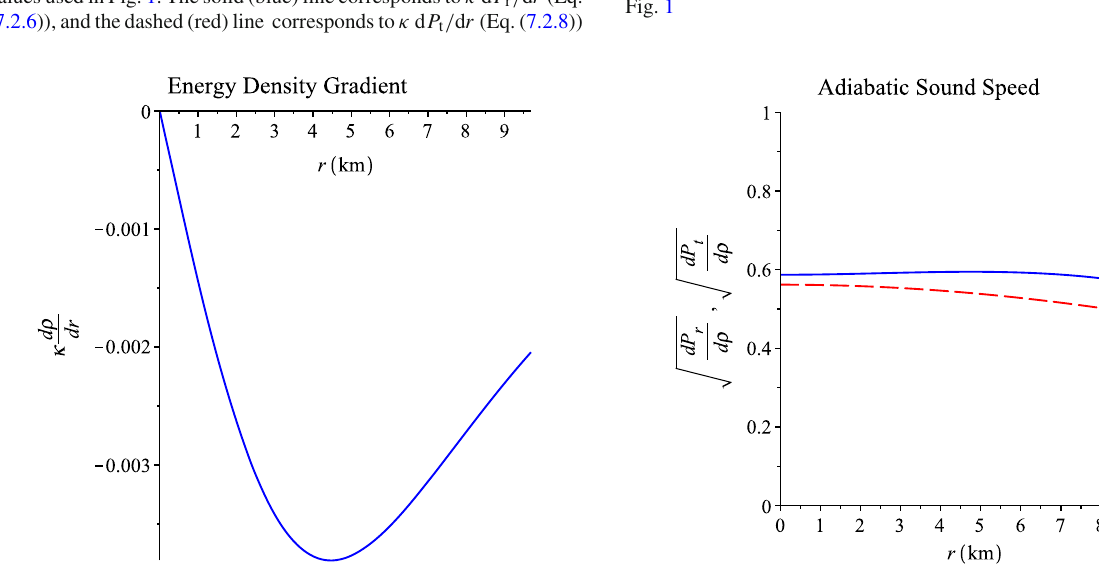
Fig. 6 Plot of equation of state P r (ρ) for the parameter values used in Fig. 1